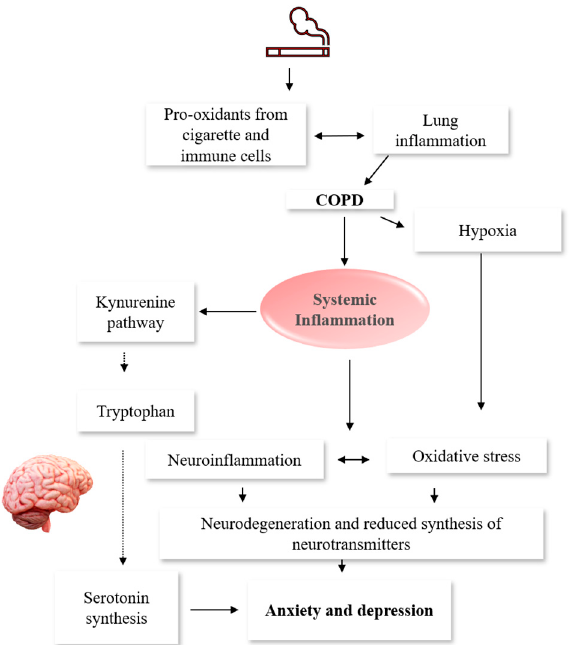
Figure 3. Putative Mechanisms of Increased Risk of COPD Patients to Mood Disorders. Reactive oxygen species from exposure to cigarette smoking accumulate in the lungs and trigger local inflam- mation. The lung inflammatory mediators spill into the plasma, where systemic inflammation sets in. Systemic inflammation activates the Kynurenine pathway. Hence, more tryptophan is degraded into kynurenines, limiting its transport into the brain for serotonin synthesis, leading to anxiety and depression. In addition, inflammatory mediators cross the blood–brain barrier, causing neurode- generation and reduced synthesis of neurotransmitters, also resulting in anxiety and depression. Furthermore, hypoxia associated with COPD could lead to neuronal damage, thus interfering with the production of neurotransmitters. COPD: chronic obstructive pulmonary disease.